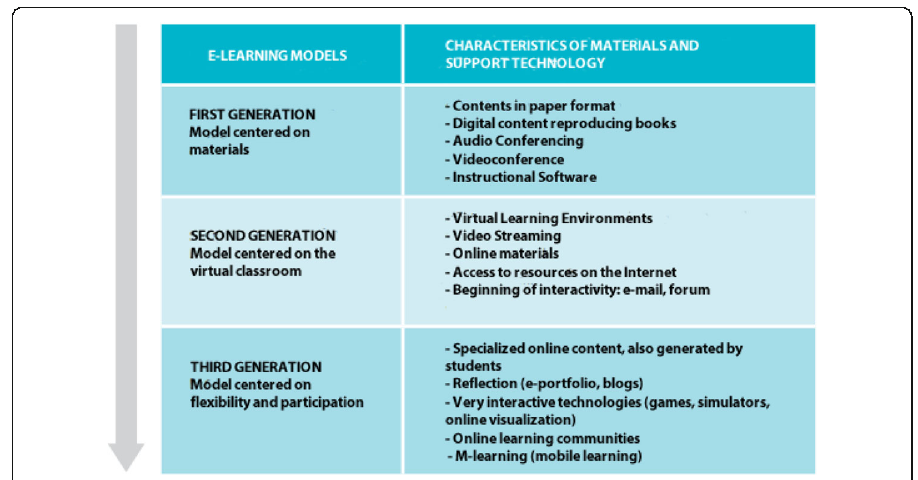
Fig. 3 Evolution of educational models, materials and support technologies in the UOC. Source: (UOC, 2009, p.